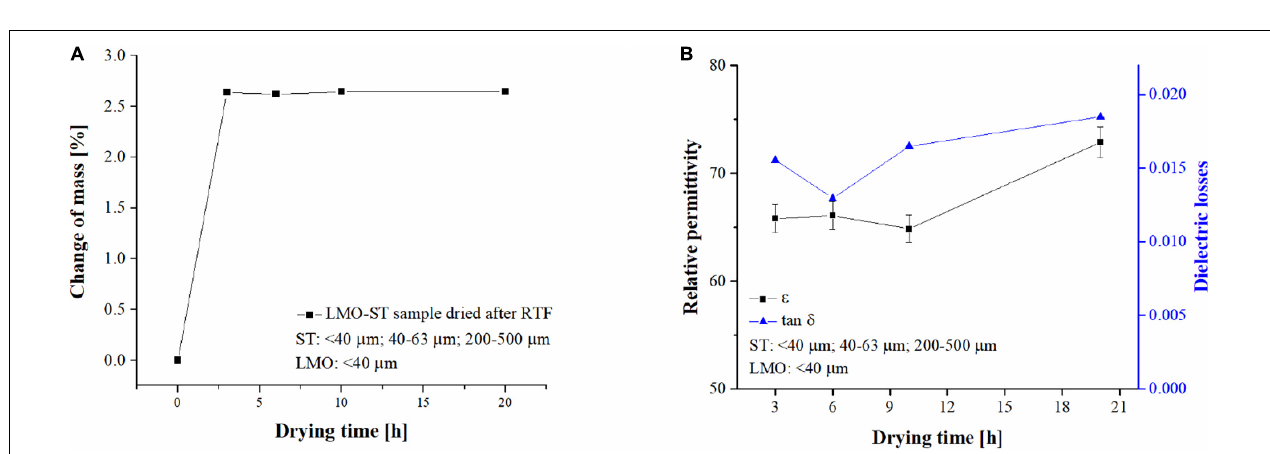
FIGURE 7 | (A) Mass of LMO-ST composite changing over drying time. (B) Relative permittivity and dielectric losses as a function of drying time.